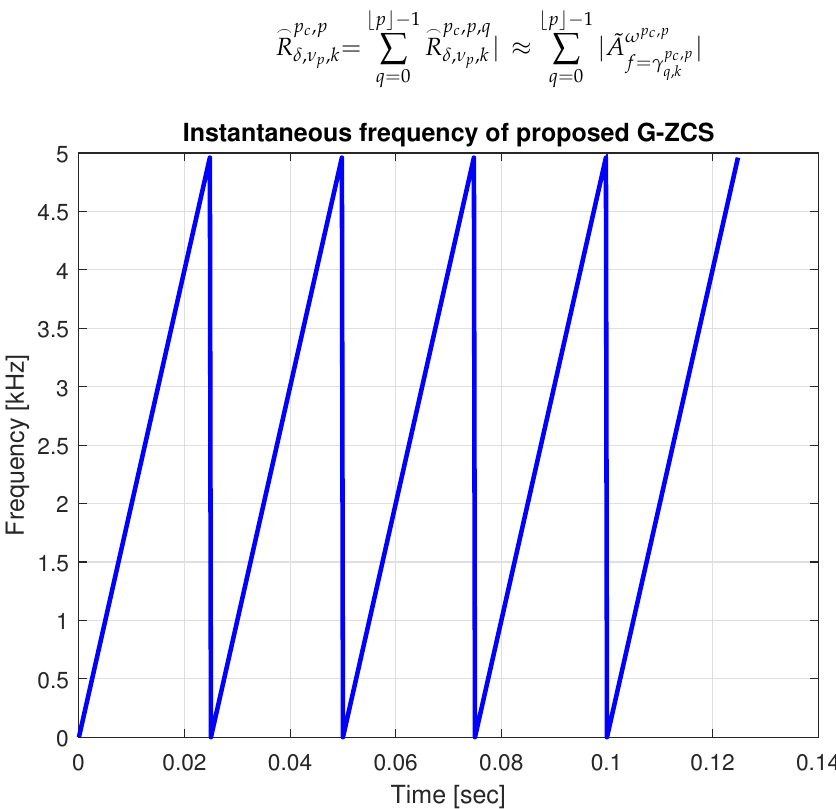
Figure 2. Instantaneous frequency of proposed